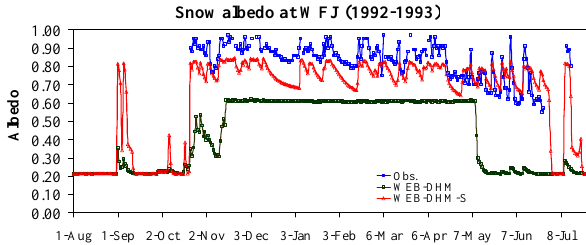
Fig. 5. Comparison of simulated daily snow albedo with the observed values at WFJ (1992–1993) from 1 August 1992 to 31 July 1993.